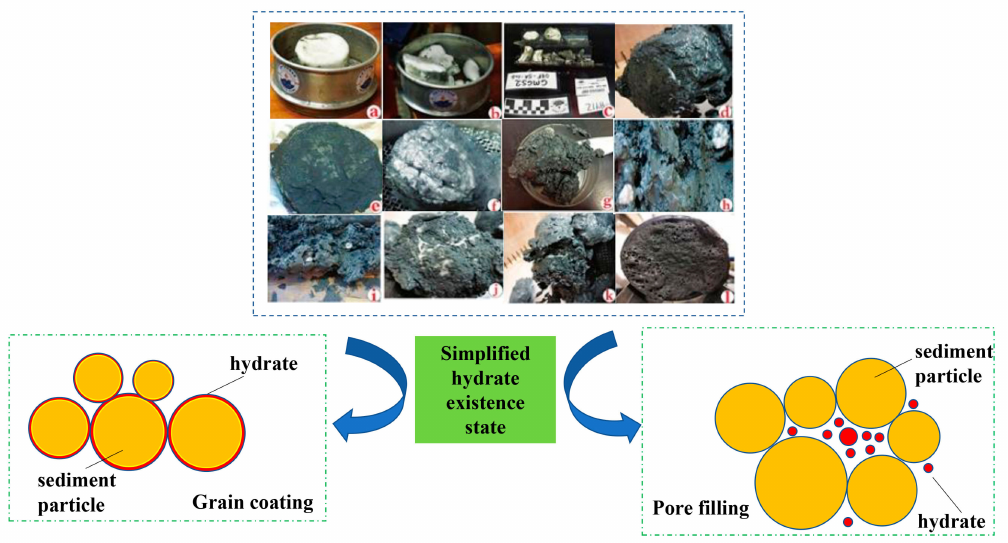
Figure 2. The natural samples and simplified modes of NGHs. ( a – c ) Massive hydrate; ( d , e ) thin layers of hydrate; ( f ) nodular hydrate; ( g – i ) concretion hydrate; ( j , k ) vein hydrate; ( l ) disperse